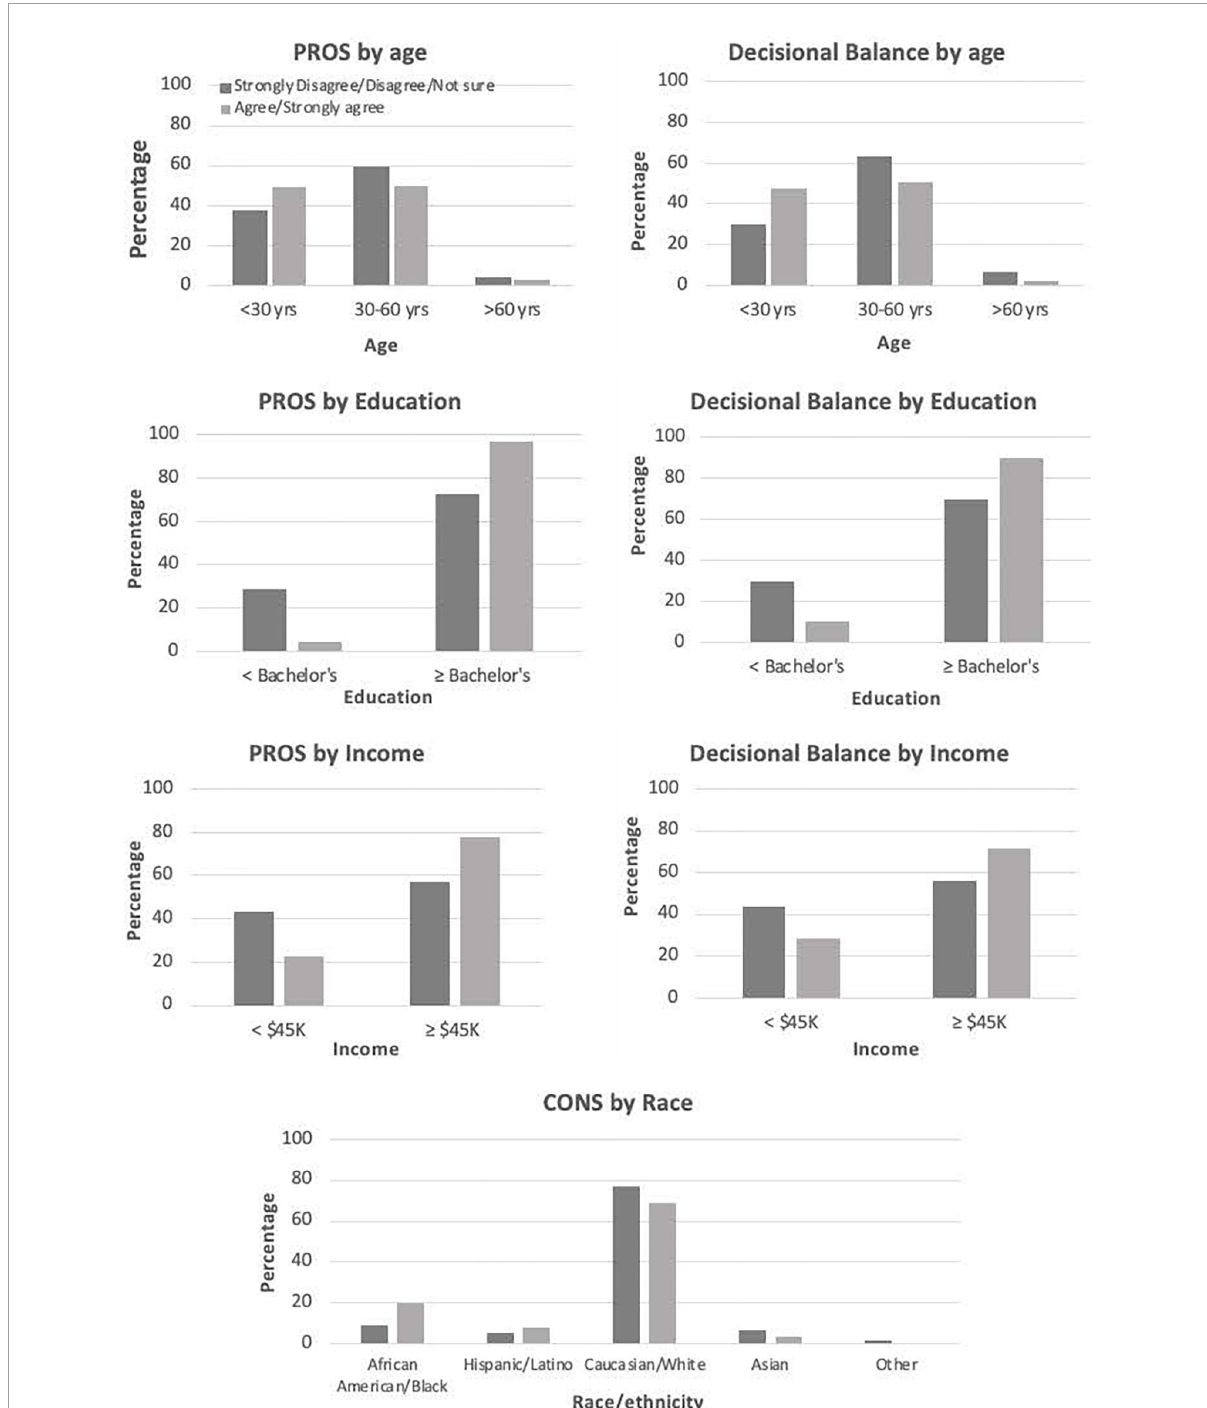
FIGURE2 Significant ( p < 0.05) differences in pros, cons, and decisional balance by demographic